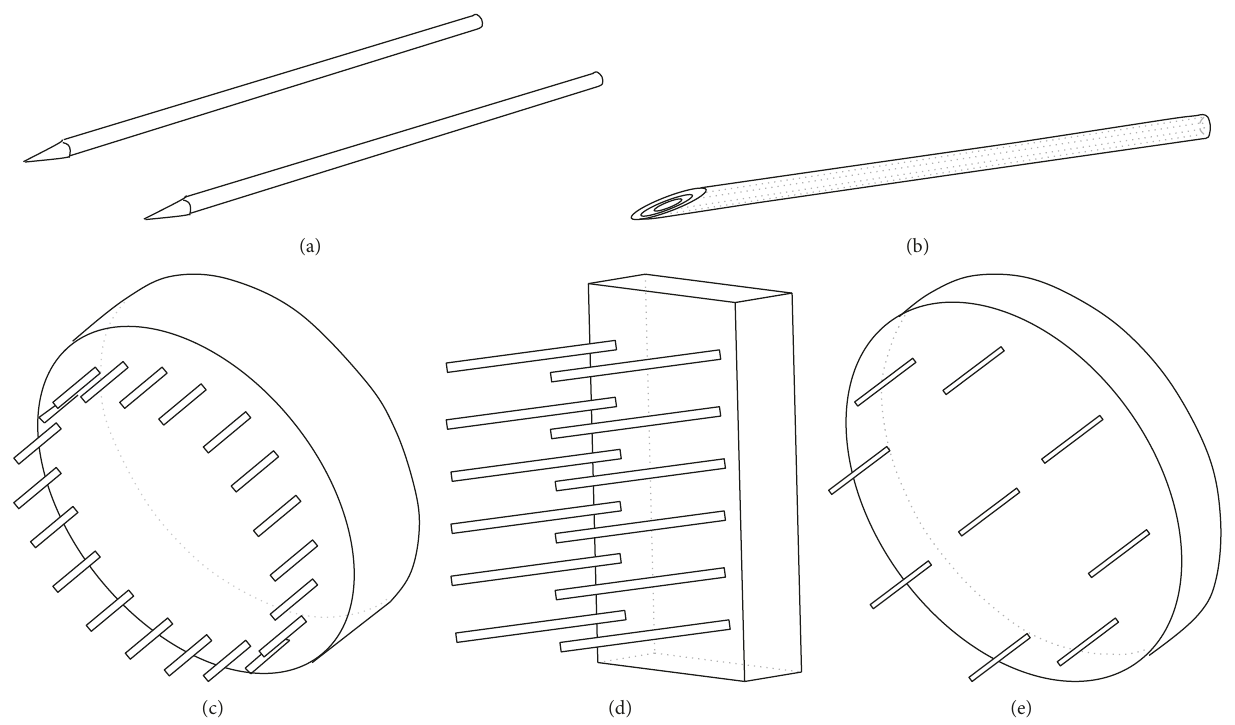
Figure 6: Schematic diagrams of five configurations of bipolar